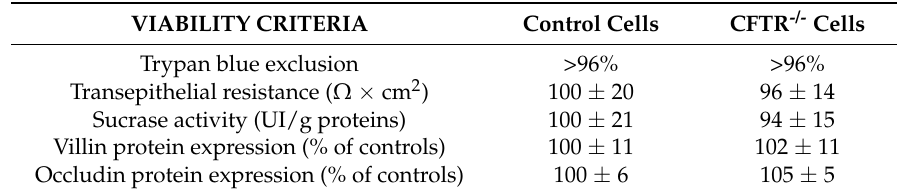
Figure 1. CFTR gene and protein expression in control and CFTR -/- Caco-2/15 cells. Knockout of the CFTR gene by the ZFN technology resulted in full deletion of mRNA and protein expression, which were assessed by RT-PCR and Western blot, respectively. The CFTR -/- cell line is thus appropriate to mimic the homozygous CF phenotype. Values are means ± standard error of the mean (SEM) of 3 independent experiments. *** p < 0.001 vs. CTR cells. CTR: control cells; ZFN: zinc finger nuclease. Table 1. CFTR knockout and Caco-2/15 cell